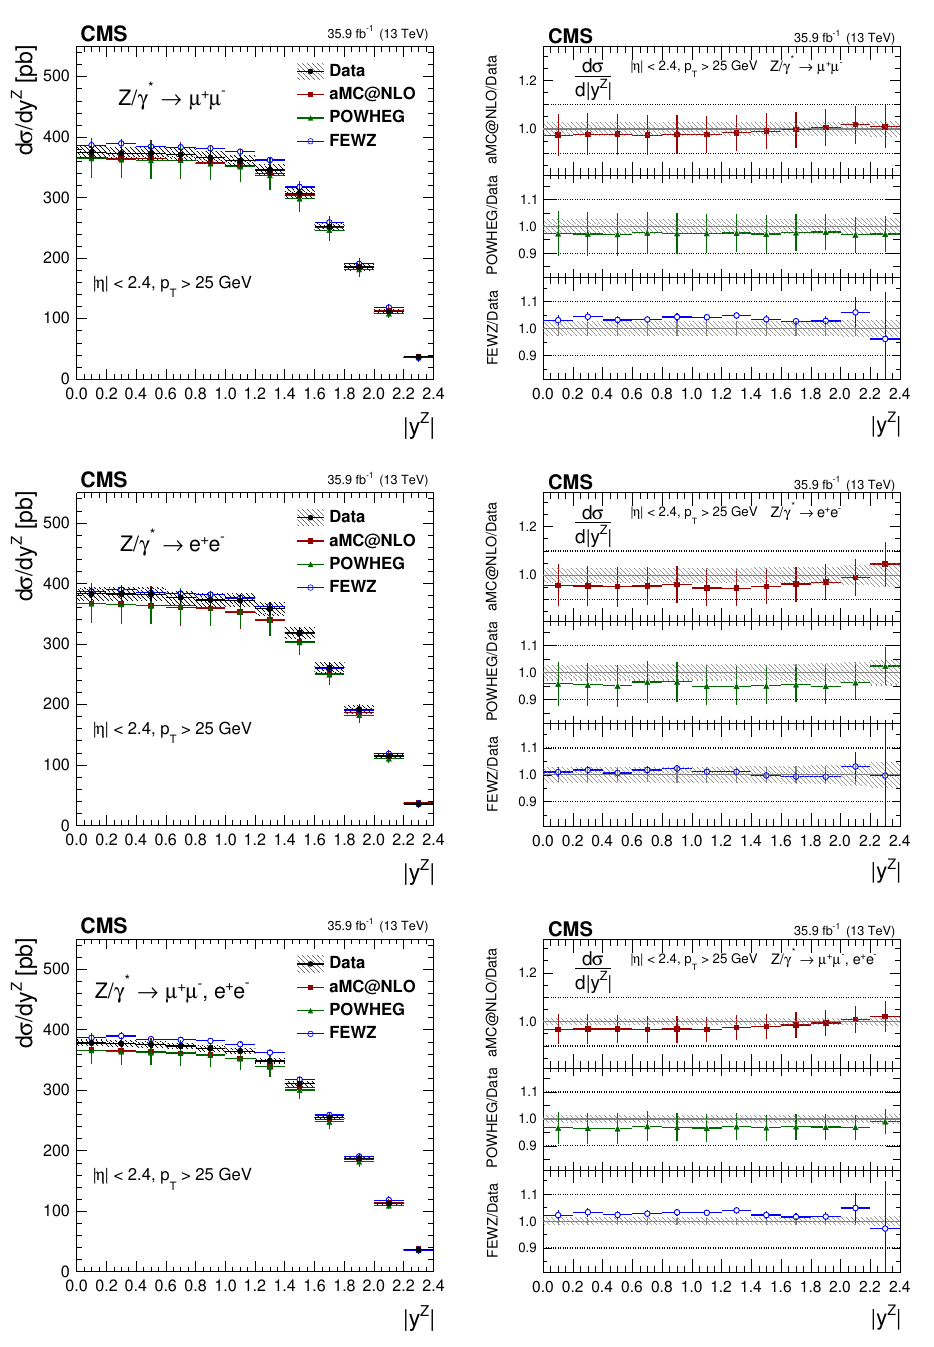
Figure 5 . The measured absolute cross sections (left) in bins of j y Z j for the dimuon (upper) and dielectron (middle) (cid:12)nal states, and for the combination (lower). The ratios of the predictions to the data are also shown (right). The shaded bands around the data points (black) correspond to the total experimental uncertainty. The measurement is compared to the predictions with Mad- Graph 5 a mc@nlo (square red markers), powheg (green triangles), and FEWZ (blue circles). The error bars around the predictions correspond to the combined statistical, PDF, and scale uncer- tainties.